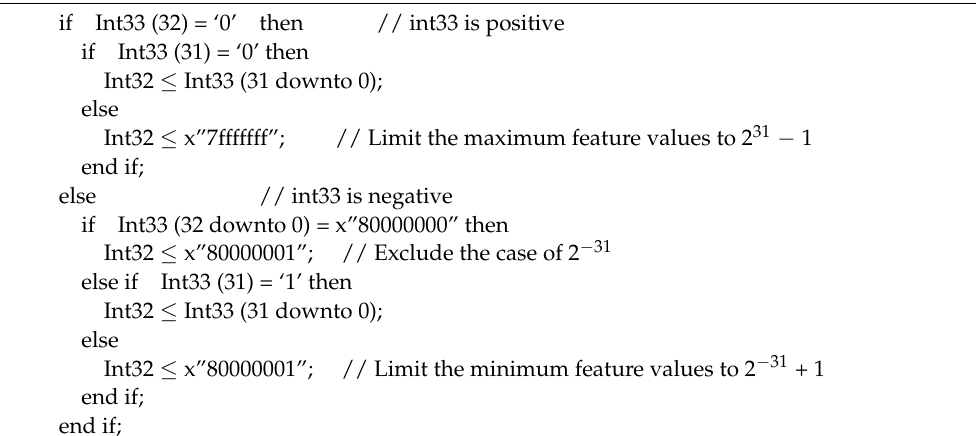
Algorithm 1. The pseudo-code of the clamp operation in hardware implementation.